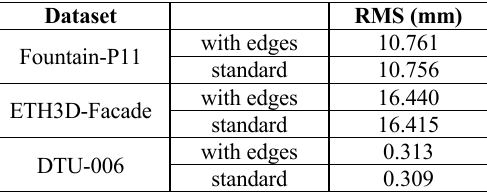
Table 1. RMS errors for the three